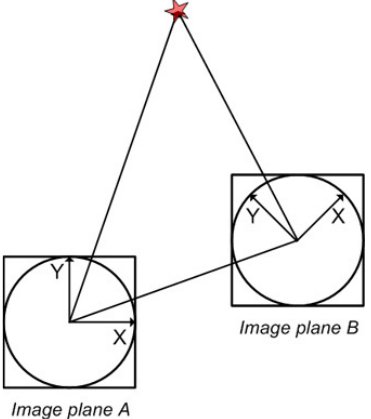
Figure 5. Interpretation of the valid solution pair ( R 1 , t x ), on the plane